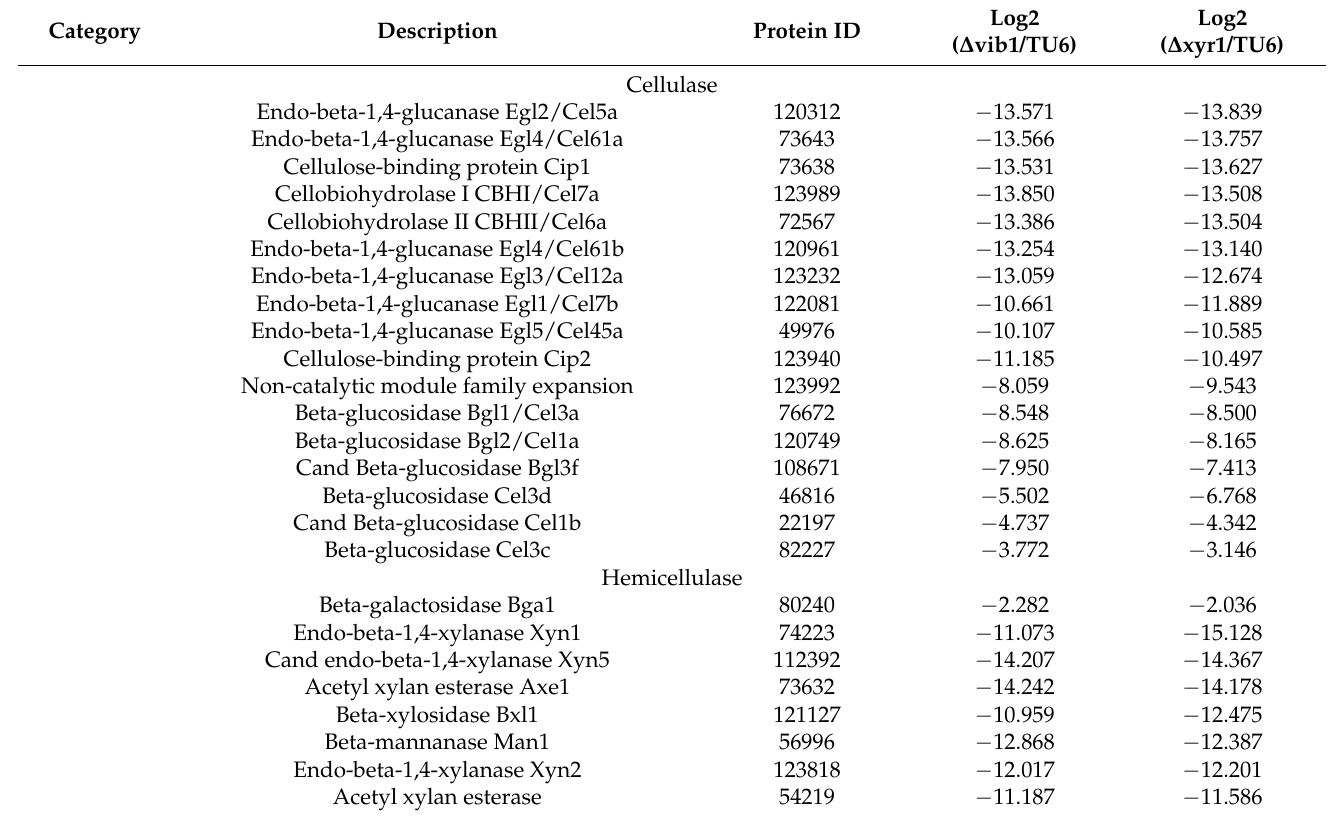
Table 2. Fold change of genes encoding cellulase, hemicellulase, sugar transporter, and transcription factor of the Avicel regulon in Δ vib1 and Δ xyr1 on Avicel .